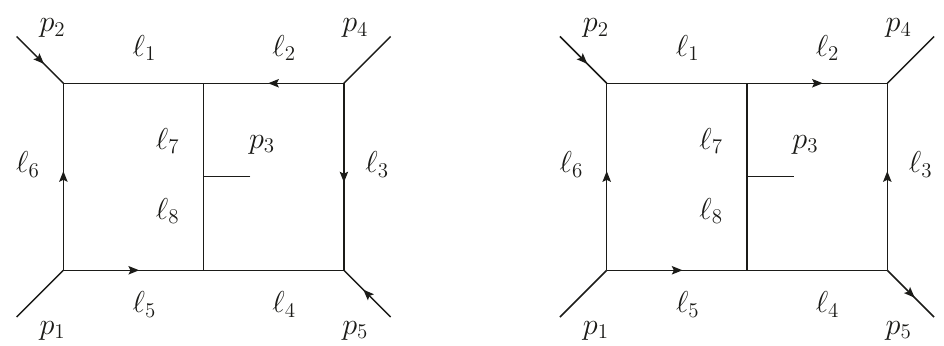
(left) and N a (right). The arrows depict 1 2